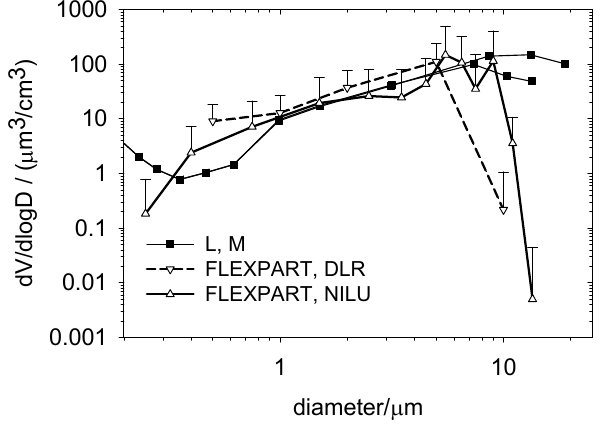
Fig. 20. Volume size spectra as derived from the measurements (L, M) and from simulation (FLEXPART, DLR and NILU) inside the ash cloud (leg 10 of Table 3, 16:11:45–16:19:55UTC) for 17 May. The higher measured result is for case M. The simulations use dif- ferent ash source parameters. The error bars to the model results reflect the standard deviations along the flight